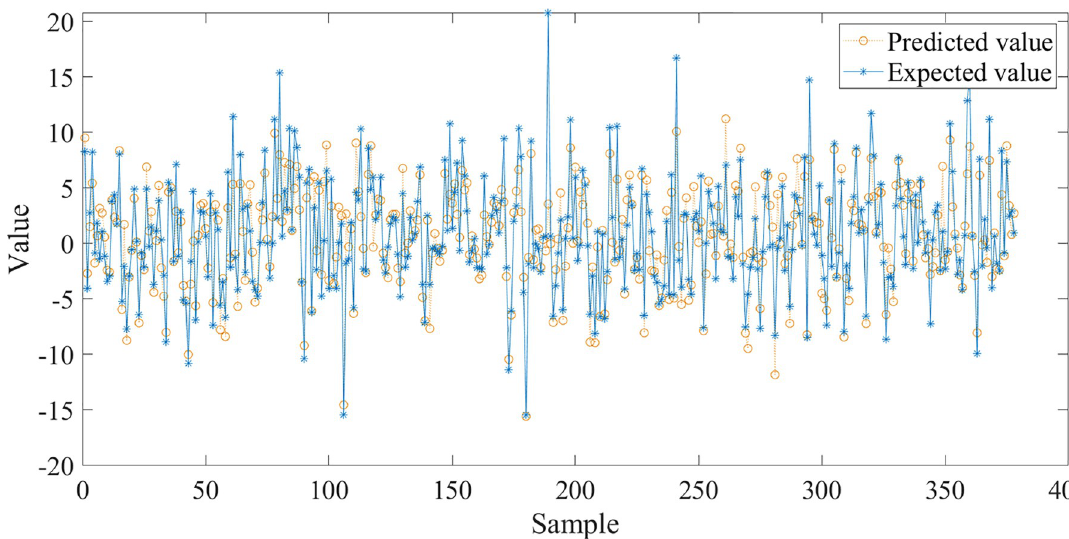
Fig 4. Comparison of predicted and expected value of BP neural network.